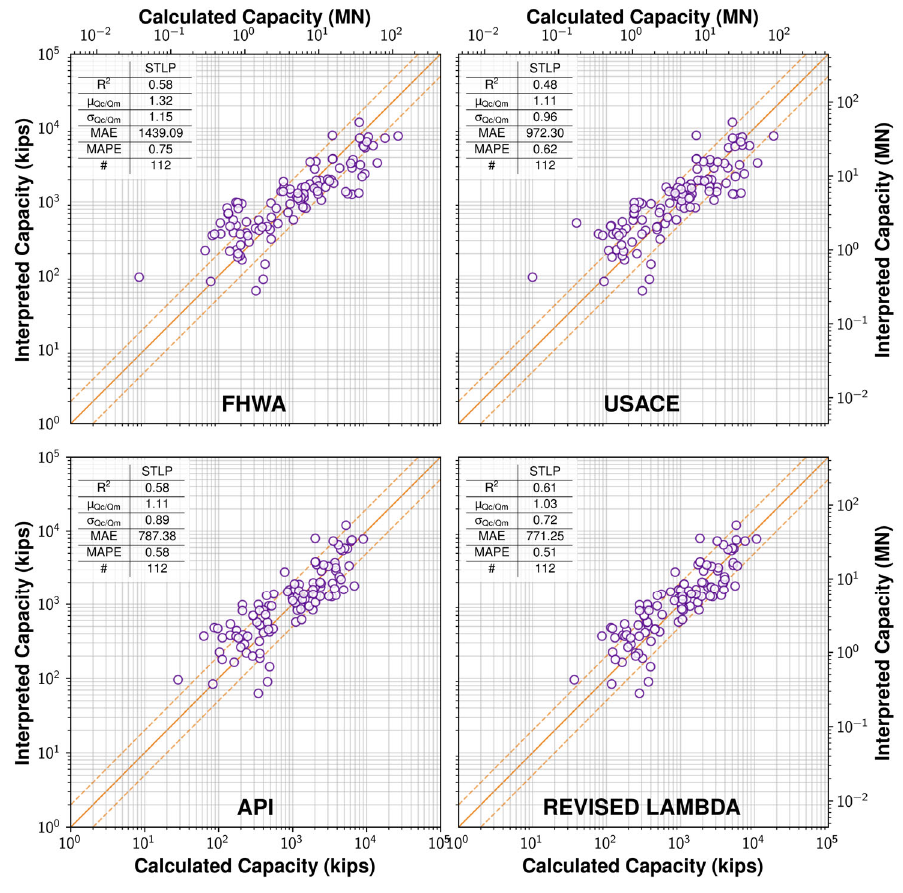
Figure 3. Performance of traditional methods. (1:1, 1:0.5, and 1:2 lines were also plotted in orange to facilitate comparison on a log ‐ log scale)